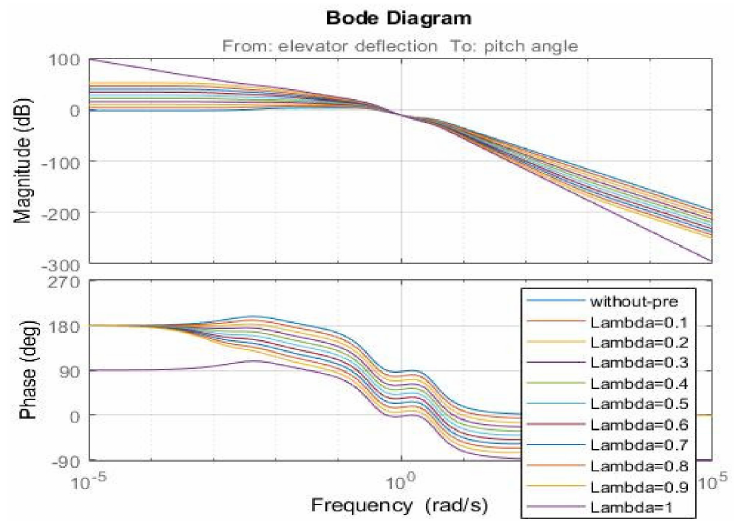
Figure 9. Open-loop Bode plots of the plant with and without FI